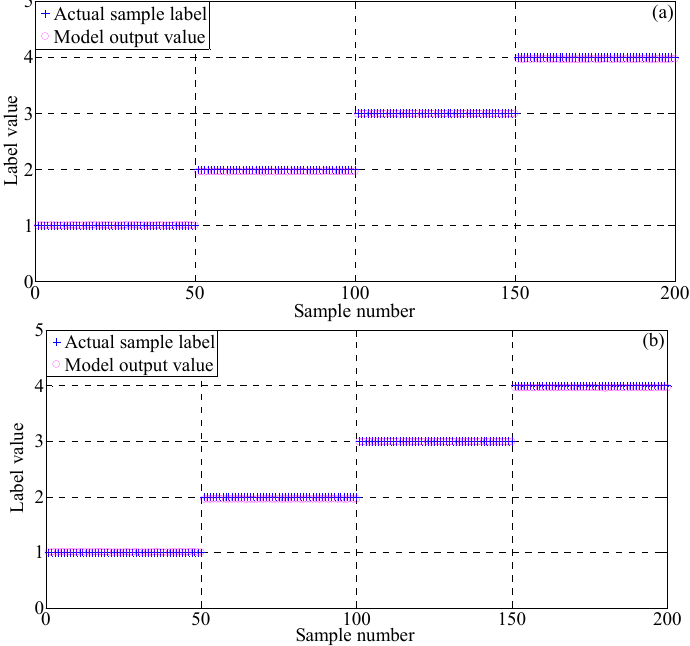
Figure 7. ( a ) Training results and ( b ) testing results for dataset I by SDAE.